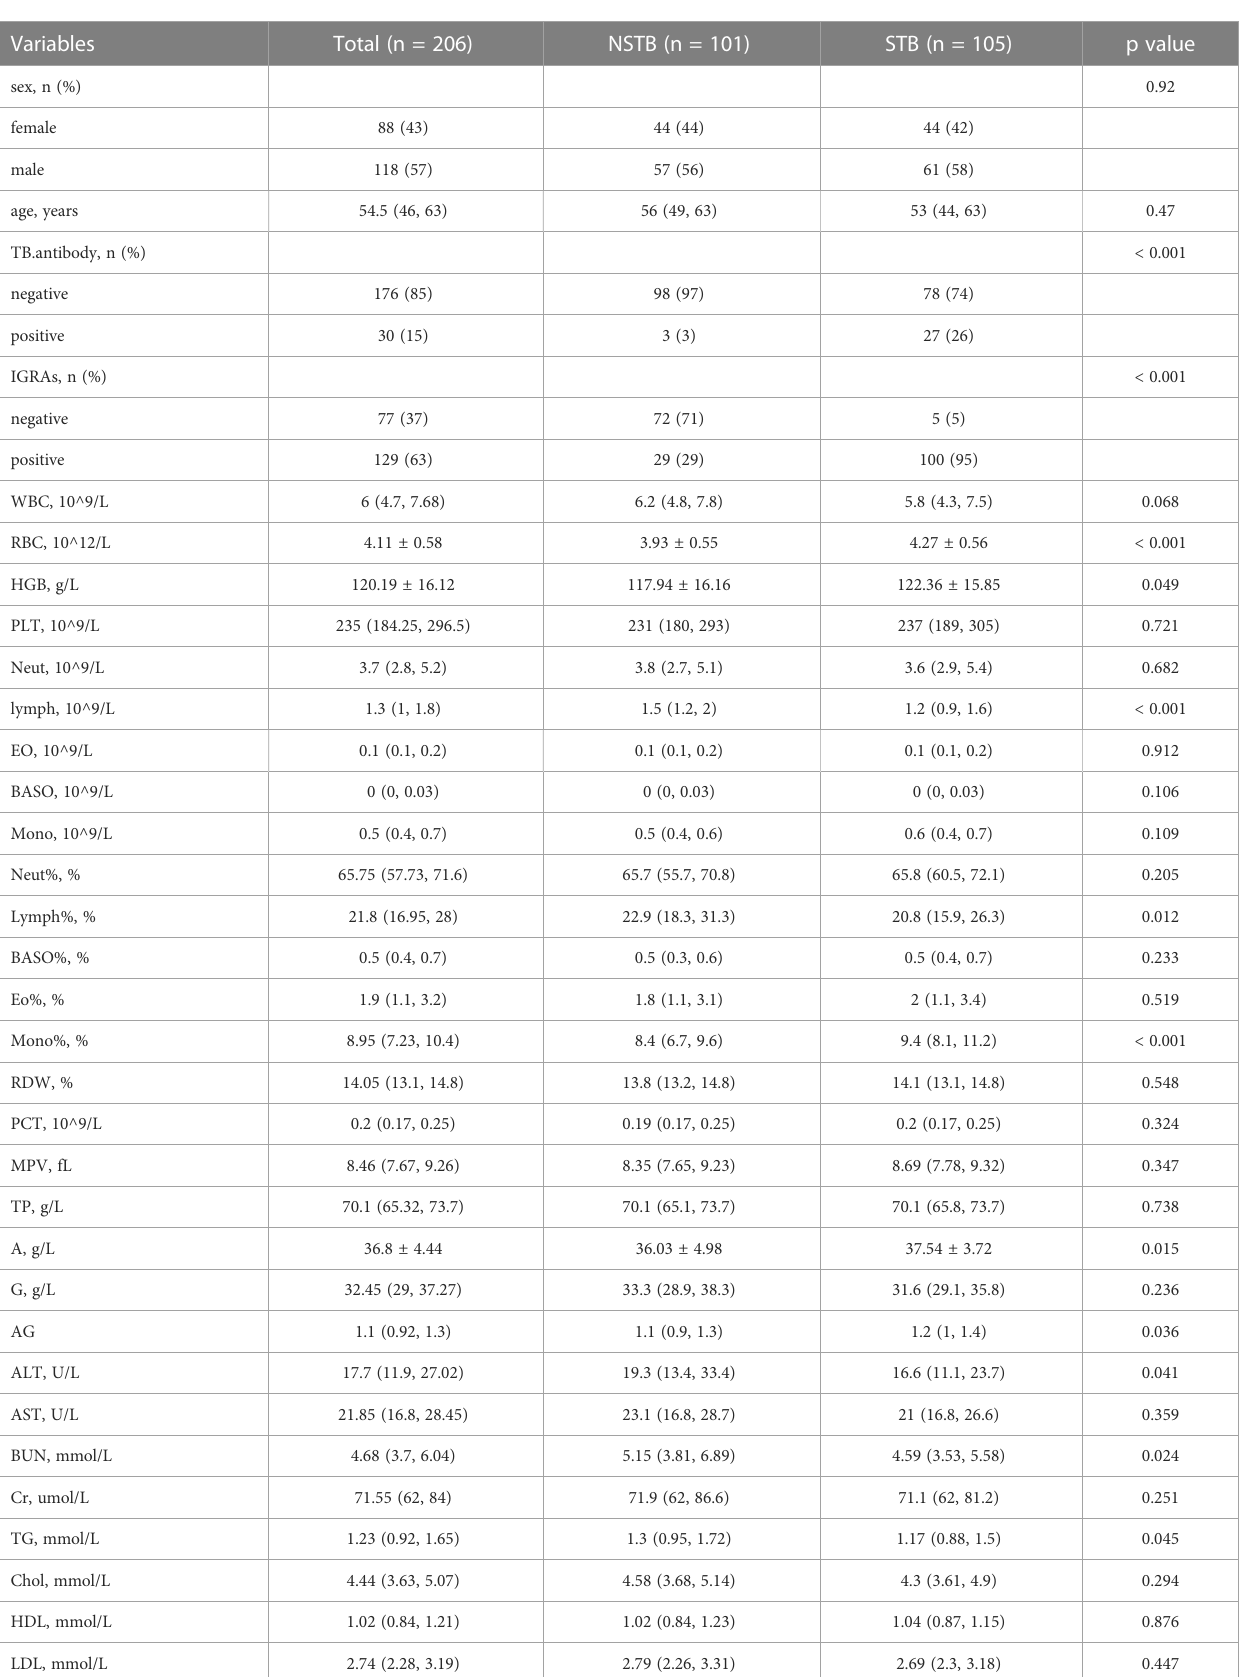
TABLE 1 Univariate analysis of patients and variables for included